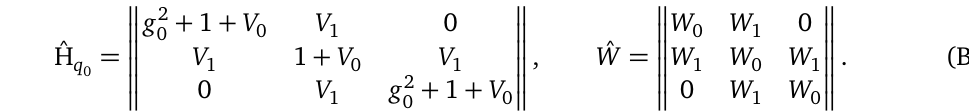
Figure 6: Periodical band structure for the case (cid:99) sented by the lowest three eigenvalues of the matrix ˆ (cid:72) calculation was made for N